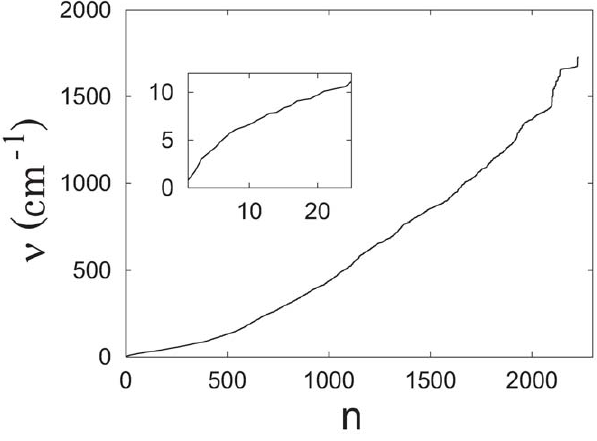
Figure 11. Normal mode (NM) spectrum for ligand-free PDC109 ( n =NM index). The inset shows an expansion of the low frequency range.